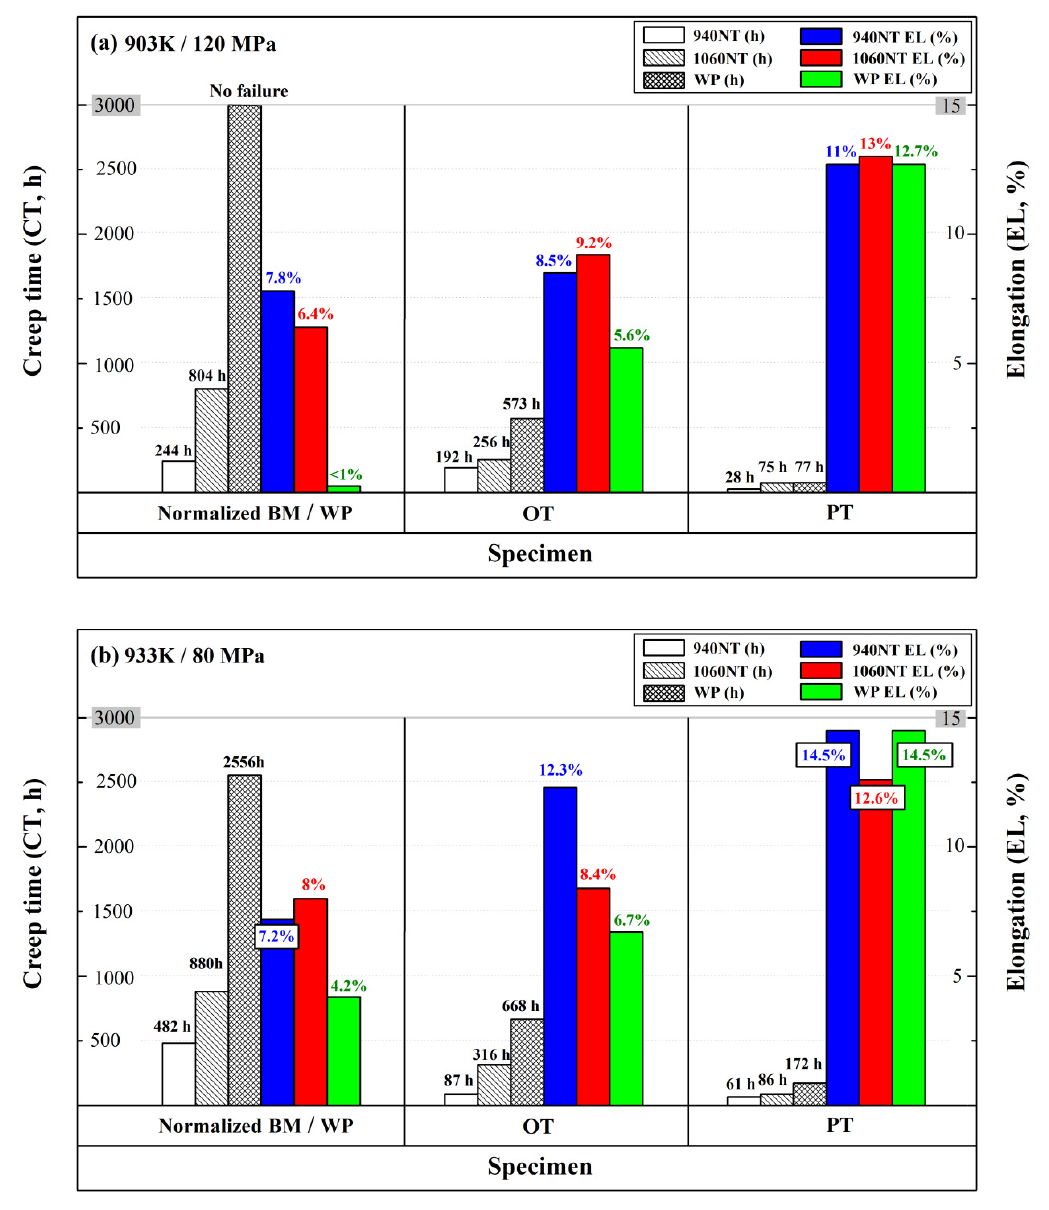
Figure 9. Short-term creep tests of specimens loaded under ( a ) 903 K/120 MPa and ( b ) 933 K/80 MPa